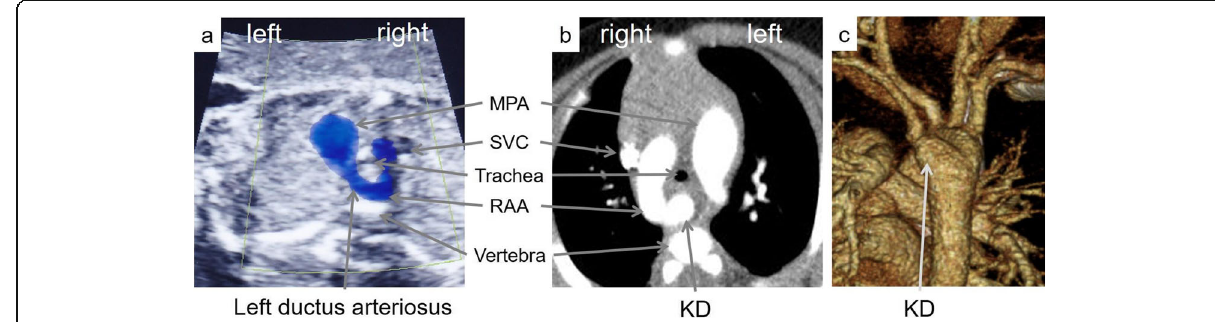
Fig. 1 Prenatal ultrasonography and chest CT at preoperative status describing the RAA, retroesophageal LSCA, and KD leading to tracheal